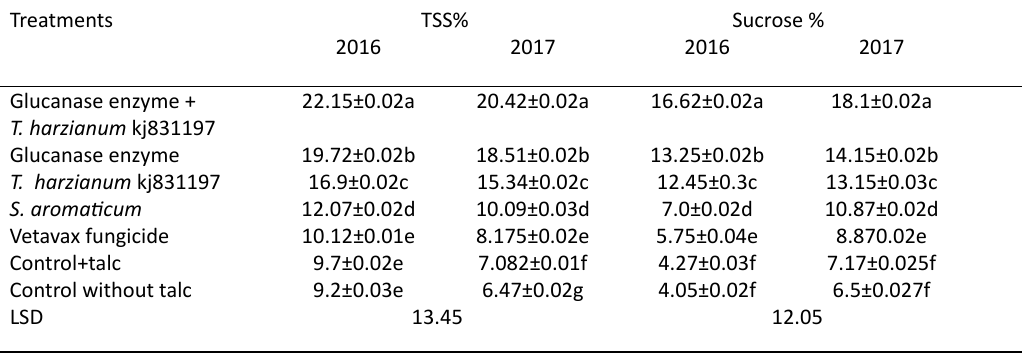
table 4. Effect of different treatments on TSS, and sucrose content of sugar beet during growing seasons Treatments TSS% Sucrose % 2016 Glucanase enzyme + 22.15±0.02a 20.42±0.02a 16.62±0.02a 18.1±0.02a T. harzianum kj831197 Glucanase enzyme 19.72±0.02b 18.51±0.02b 13.25±0.02b 14.15±0.02b T. harzianum kj831197 16.9±0.02c 15.34±0.02c 12.45±0.3c 13.15±0.03c S. aromaticum 12.07±0.02d 10.09±0.03d 7.0±0.02d 10.87±0.02d Vetavax fungicide 10.12±0.01e 8.175±0.02e 5.75±0.04e 8.870.02e Control+talc 9.7±0.02e 7.082±0.01f 4.27±0.03f 7.17±0.025f Control without talc 9.2±0.03e 6.47±0.02g 4.05±0.02f 6.5±0.027f LSD 13.45